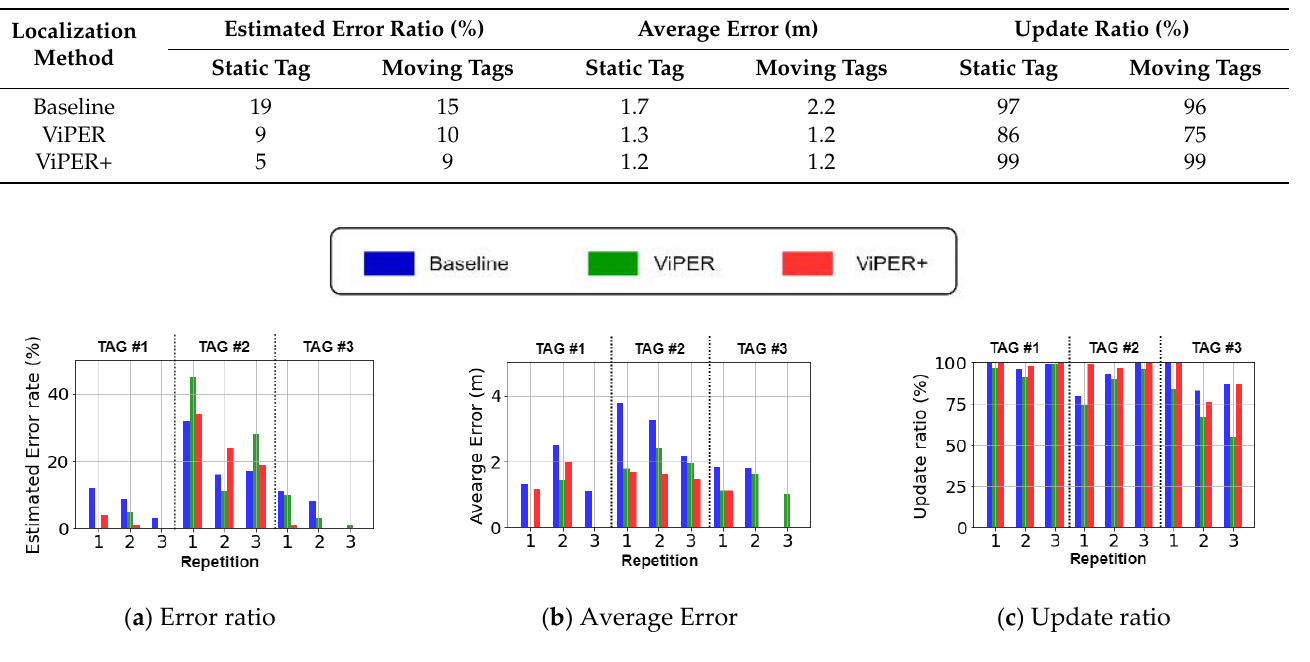
Table 6. The results of worker tracking for NLOS scenario with blocking object.